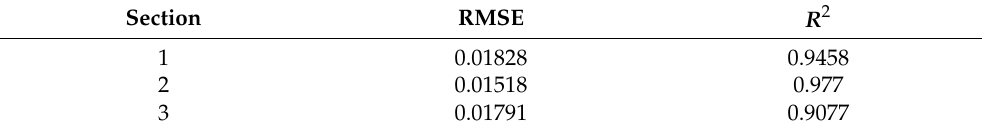
Table 2. RMSE and 𝑅 (cid:2870) values of mean streamwise velocities on the three cross ‐ sections. Section